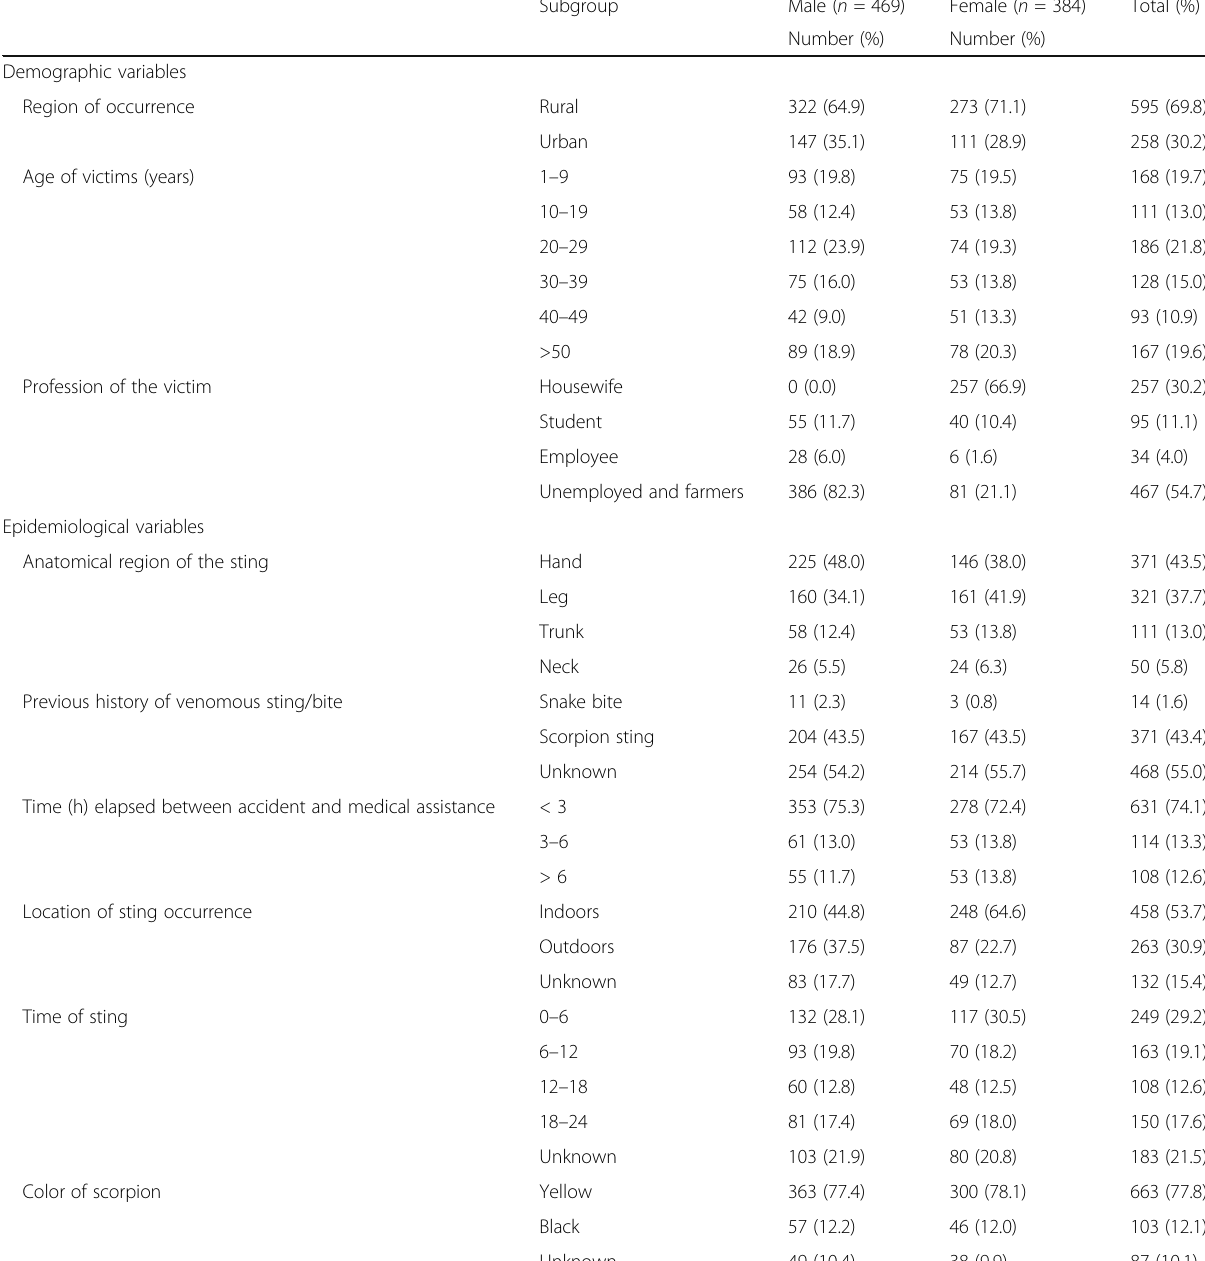
Table 2 Demographic and epidemiological characteristics of patients ( n = 853)